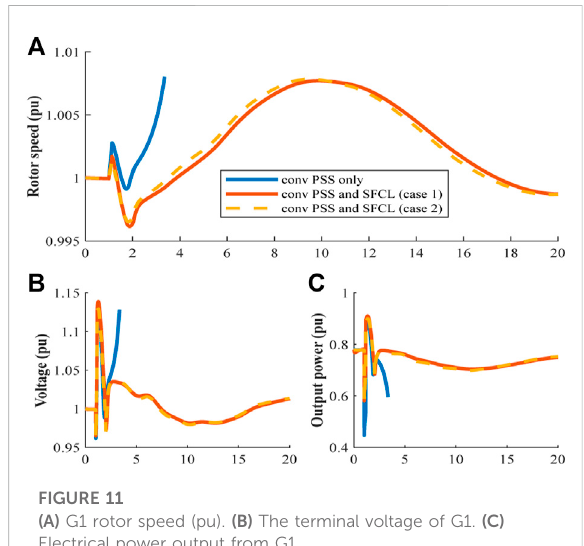
FIGURE 11 (A) G1 rotor speed (pu). (B) The terminal voltage of G1. (C) Electrical power output from